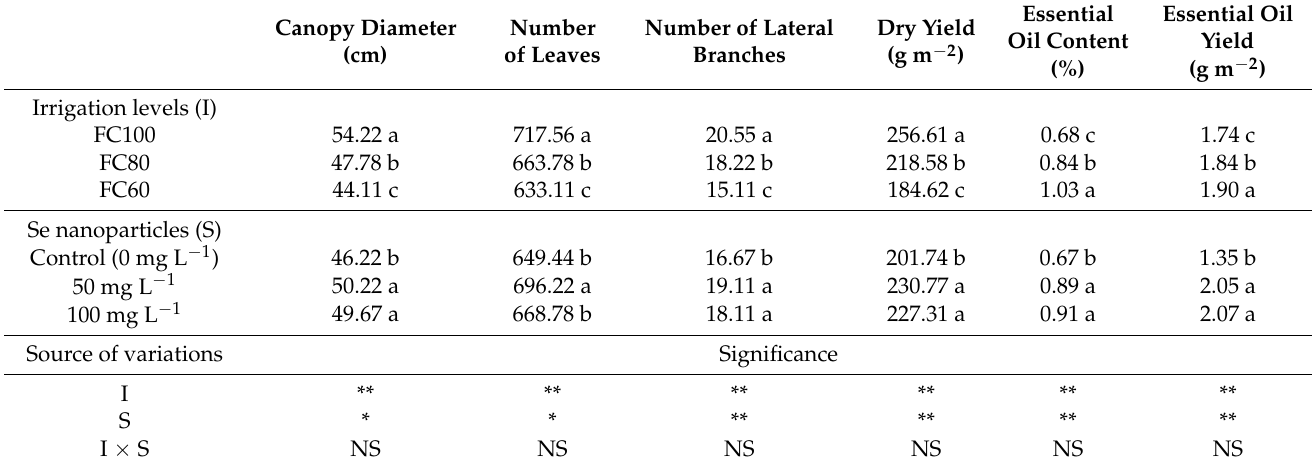
Table 2. The agronomic traits (canopy diameter, number of leaves, and number of lateral branches), dry yield, essential oil content, and essential oil yield of basil in different irrigation regimes and Se